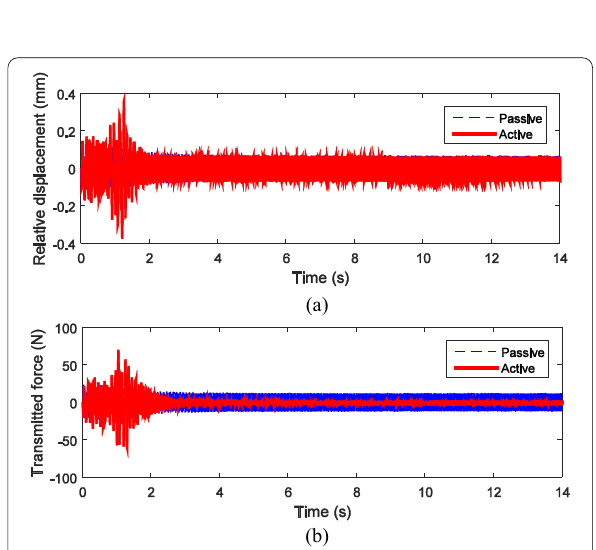
Figure 13 Comparison results of active mount and passive mount under variable engine speed conditions (engine speed increased from 750 r/min to 2100 r/min): a the relative displacement and b the transmitted